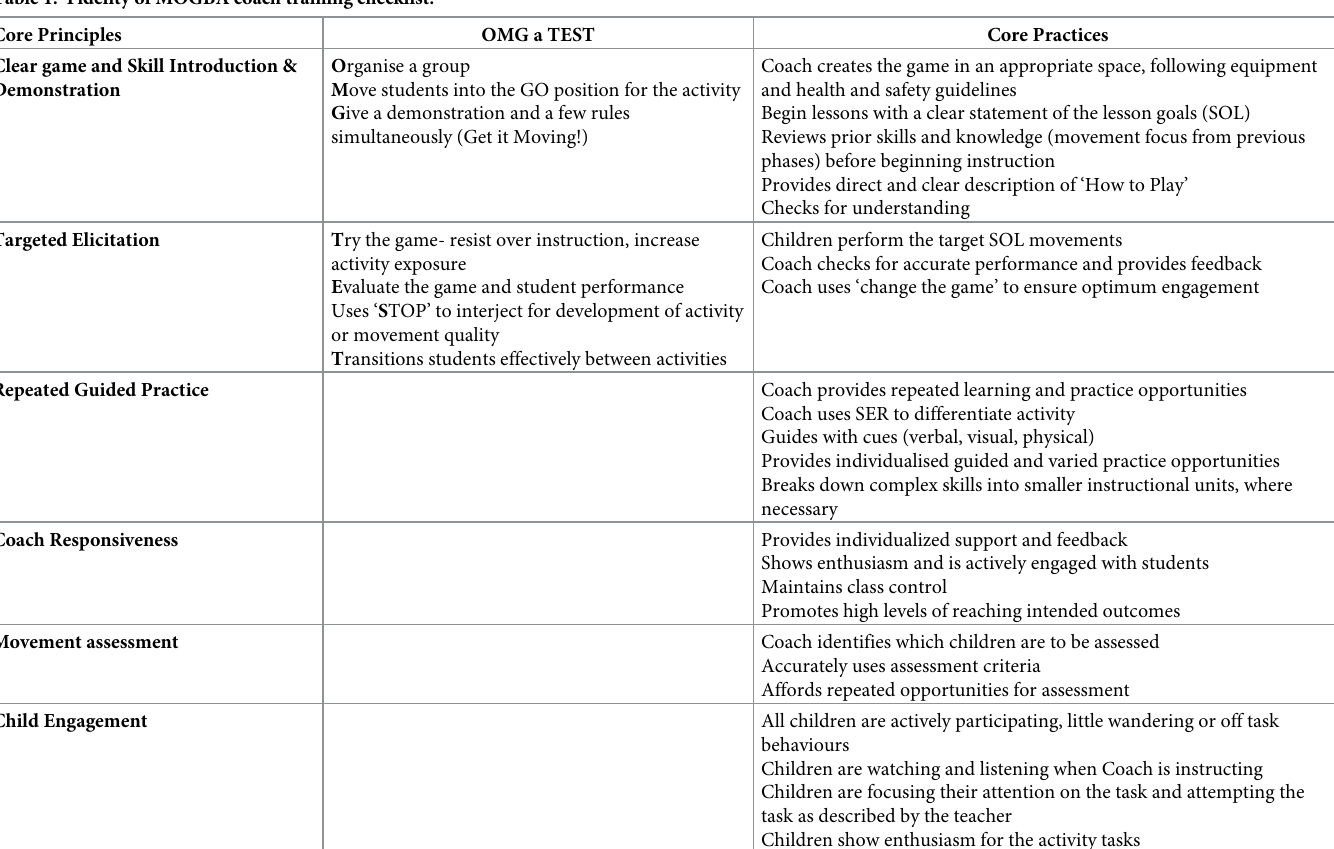
Table 1. Fidelity of MOGBA coach training